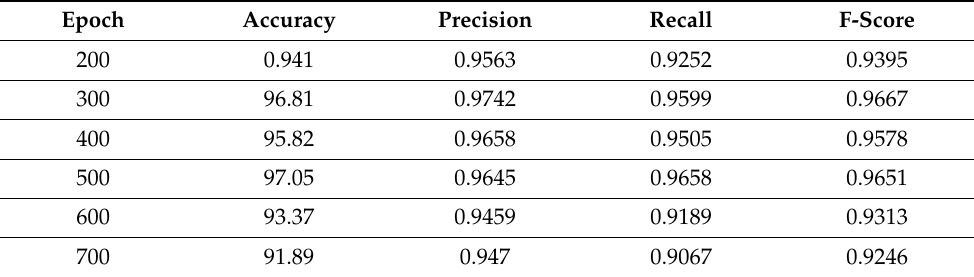
Table 3. The performance evaluation by changing the number of epochs with the 10-fold cross- validation and a batch size equal to 100.